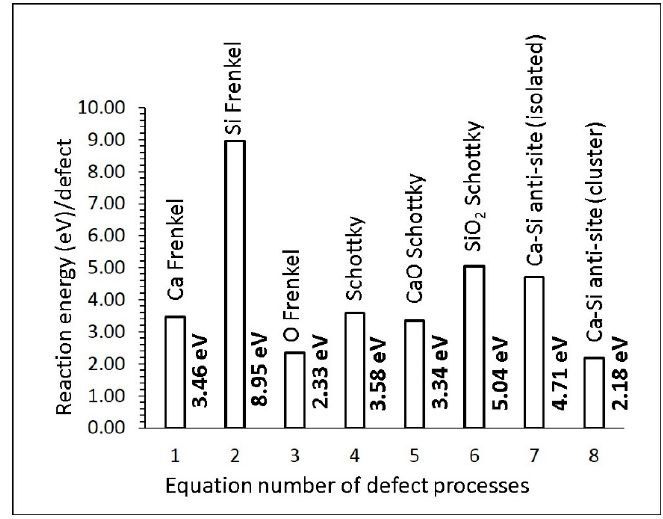
Figure 2. Defect energies for di ff erent defect processes, as shown in the above equations.